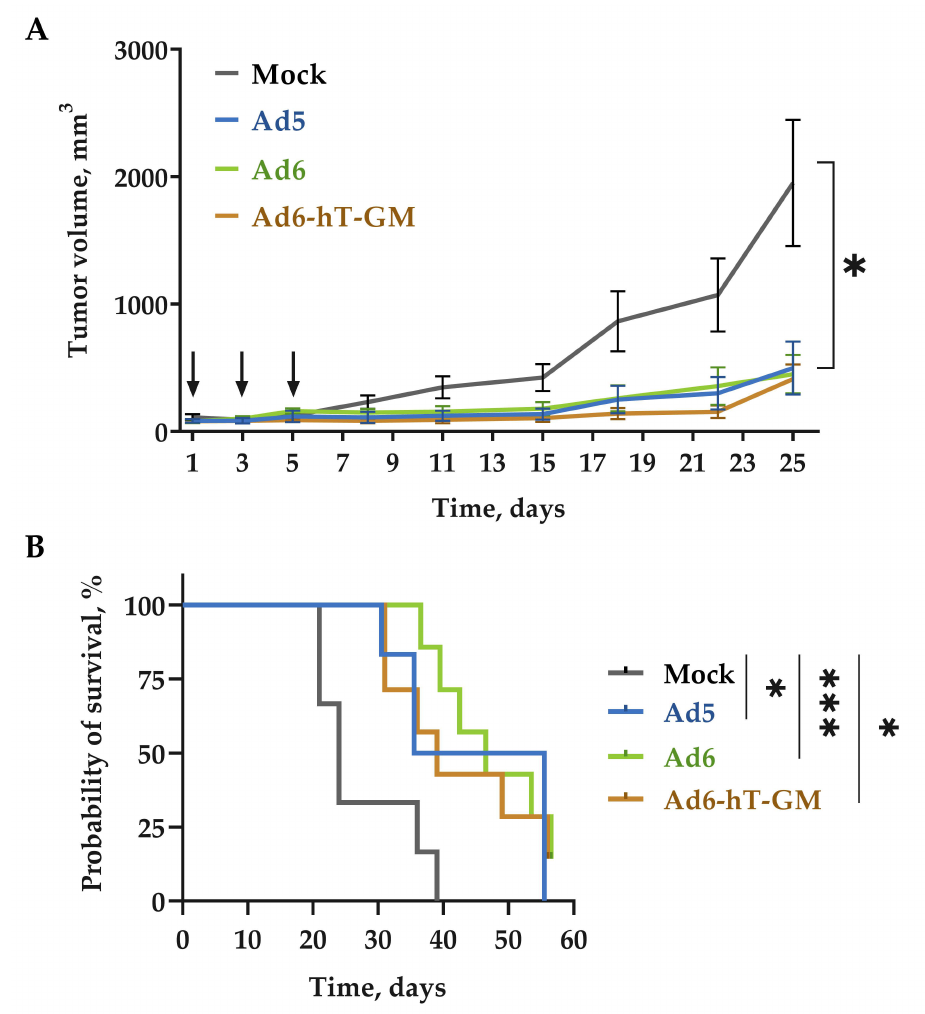
Figure 6. Oncolytic potency of adenoviruses on MDA-MB-231 bearing SCID mice. ( A ) Mean tumor volumes. SCID mice ( n = 6–7) with preestablished MDA-MB-231 tumors (approximately 100 mm 3 ) were intratumorally injected with 10 10 vp of indicated viruses at day 1, 3, and 5 (indicated by arrows). Mann-Withney test was performed between control and the treated groups. The values are presented as mean ± SEM. ( B ) Survival data were depicted as Kaplan-Meier survival curves. Comparison between treated groups and the mock group was conducted by a log-rank test. * p < 0.05, *** p <